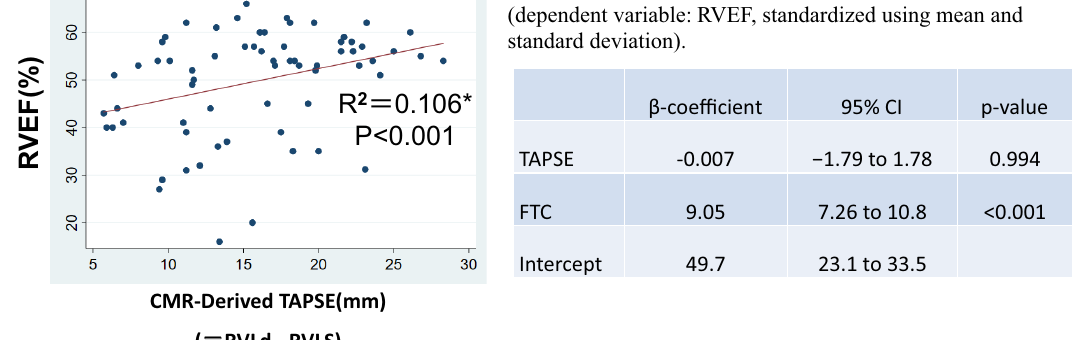
the Control group. Immobilization or adhesion of part of the myocardium may cause RV dysfunction, expressed by FTC or FLC, and impairment of bi-ventricular stroke volume. ASD is the most common congenital heart disease with left-to-right shunting in adults 21 . Defects with shunts with Qp/Qs ratios > 1.5 are considered significant and are responsible for different degrees of right heart volume overload 22 . Our study demonstrated that the Overloaded RV group had preserved RVEF and the same range of contraction parameter (FLC/FTC) values as those of the Control group, and there were statistically significant differences in T/L ratios in the Overloaded RV group compared with those in the Degenerative RV group. These findings indicate that FLC, FTC, and T/L ratio can distinguish Overloaded RV and Degenerated RV, both of which present with RV enlargement.